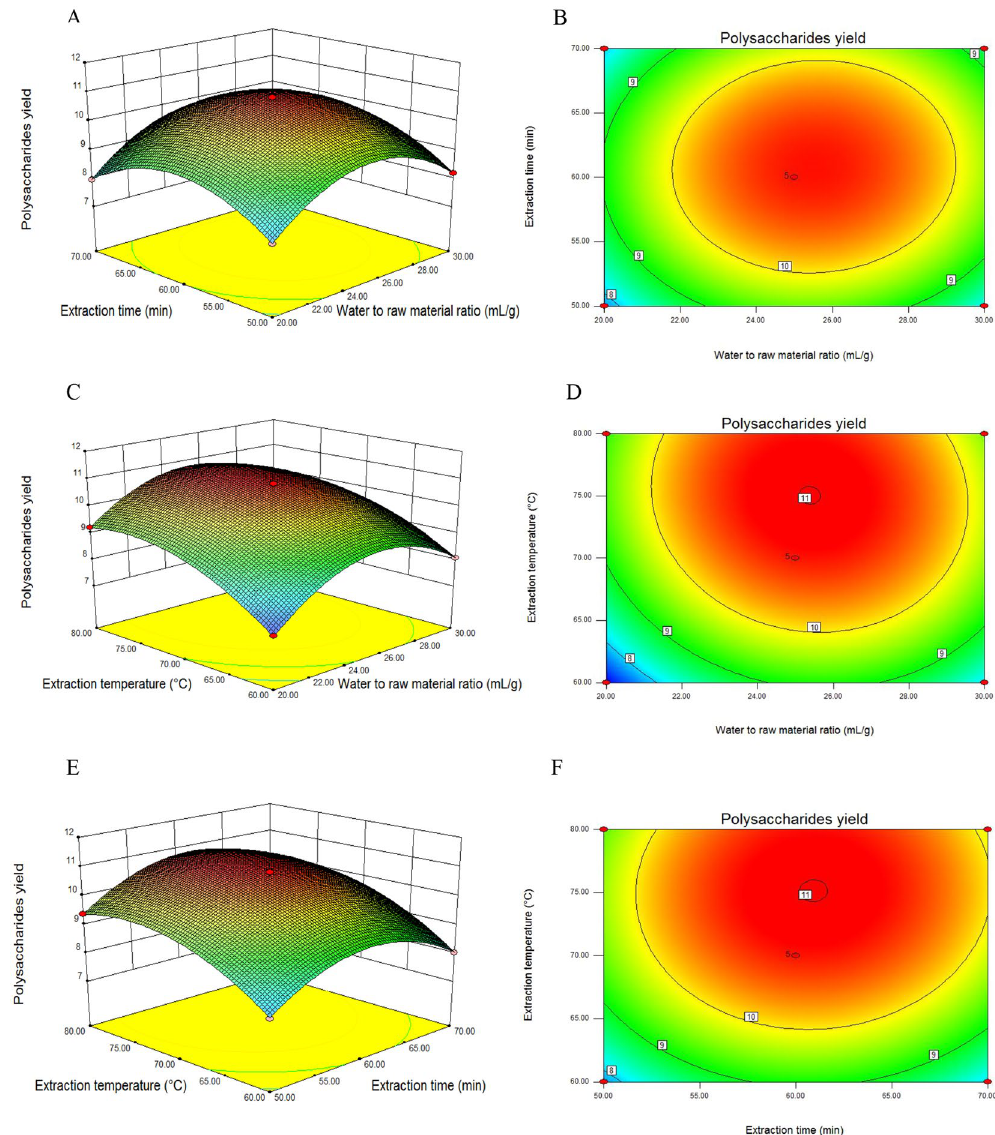
Figure 2. 3D response surface (A , C and E) and 2D contour (B , D and F) plots exhibiting the influences of the variables on the yield of Astragalus cicer L.